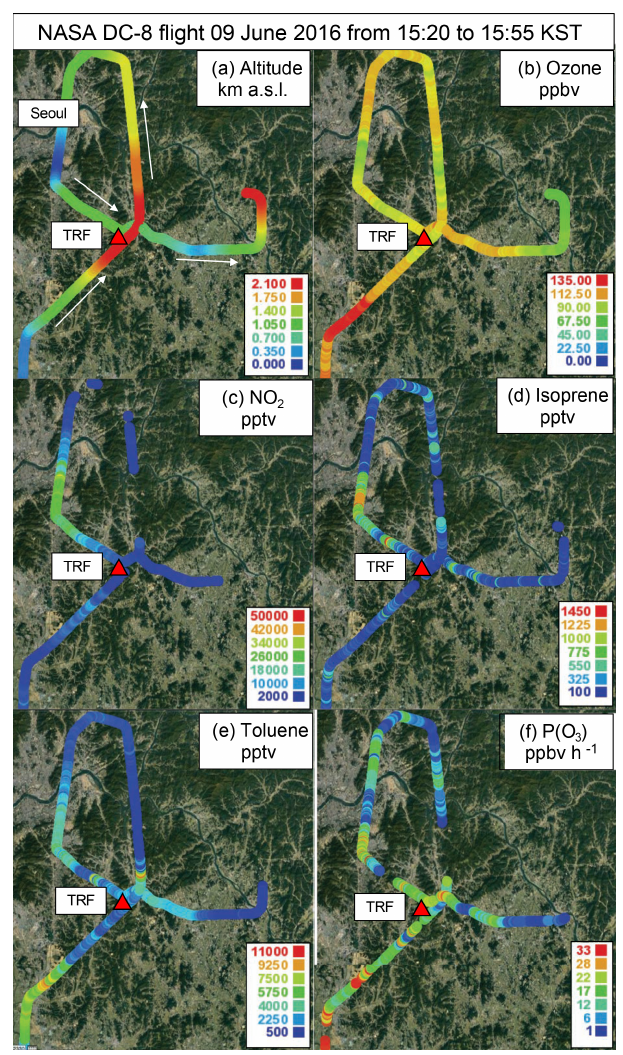
Figure 8. NASA DC-8 measurements of (a) altitude, (b) O 3 , (c) NO 2 , (d) isoprene, (e) toluene, and (f) modeled P( O 3 ) from the afternoon science flight on 17 May 2016 from 15:05 to 15:40KST.